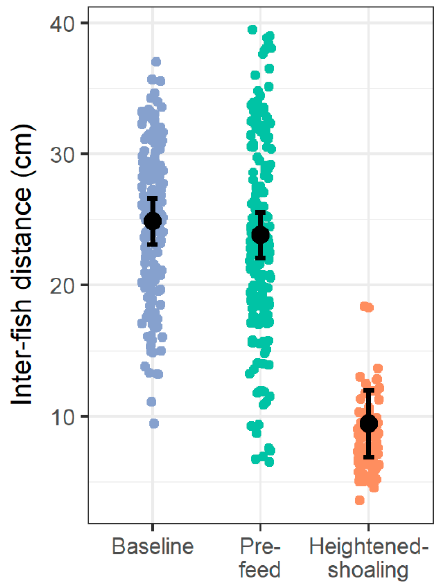
Figure 4. Inter-fish distances by period type. During heightened-shoaling, fish had significantly lower inter-fish distances compared to the other two observations periods (both p ’s < 0.0001). Small dots represent average inter-fish distances during a snapshot of fish locations within a tank and are jittered slightly to avoid overlap (45 total clips, 450 snapshots; n = 6 tanks, 10 zebrafish per tank). Larger black dots and error bars correspond to multilevel model means and 95% confidence intervals. Note nearly non-overlapping distributions between heightened-shoaling and other periods.